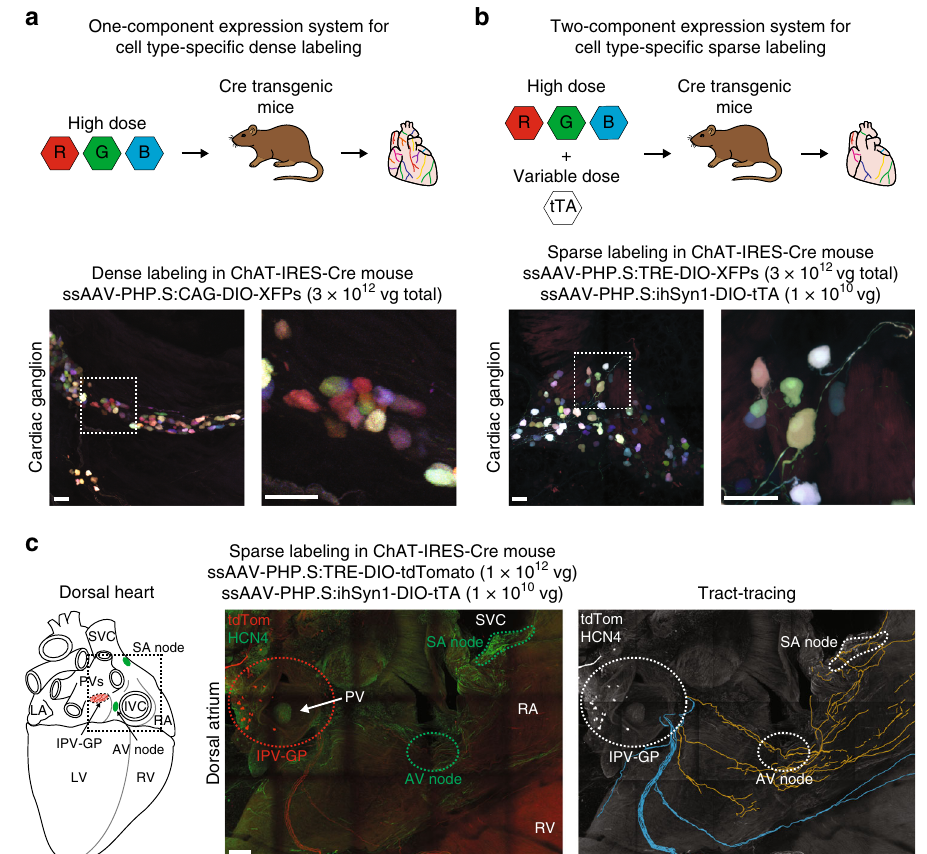
Fig. 2 AAV-based labeling and tracing of cholinergic neurons on the heart. a Schematic of the one-component expression system for cell type-speci fi c, dense multicolor labeling (top). To densely label cholinergic neurons in cardiac ganglia, ChAT-IRES-Cre mice were systemically co-administered 3 Cre- dependent vectors expressing either mRuby2, mNeonGreen, or mTurquoise2 from the ubiquitous CAG promoter (ssAAV-PHP.S:CAG-DIO-XFPs) (1 × 10 12 vector genomes (vg) each; 3 × 10 12 vg total). A MIP image of a densely labeled cardiac ganglion (bottom left). Inset shows a higher magni fi cation image (bottom right). b Schematic of the two-component expression system for cell type-speci fi c, sparse multicolor labeling (top). Expression of XFPs is dependent on cotransduction of an inducer in Cre-expressing cells. The dose of the inducer vector can be titrated to control extent of XFP labeling. To sparsely label cholinergic neurons in cardiac ganglia, ChAT-IRES-Cre mice were systemically co-administered 3 Cre-dependent vectors expressing XFPs from the TRE-containing promoter (ssAAV-PHP.S:TRE-DIO-XFPs) (1 × 10 12 vg each; 3 × 10 12 vg total) and a Cre-dependent inducer vector expressing the tTA from the ihSyn1 promoter (ssAAV-PHP.S:ihSyn1-tTA) (1 × 10 10 vg). A MIP image of a sparsely labeled cardiac ganglion (bottom left). Inset shows a higher magni fi cation image (bottom right). c To trace cholinergic fi bers, presumably from cardiac ganglia, sparse labeling was performed by systemically co-administering ssAAV-PHP.S:TRE-DIO-tdTomato at a high dose (1 × 10 12 vg) and ssAAV-PHP.S:ihSyn1-DIO-tTA at a lower dose (1 × 10 10 vg). Cartoon of the dorsal heart depicting the orientation of images (left). A MIP image of the dorsal atrium with native tdTomato fl uorescence (red) and HCN4 staining (green) (middle). Fibers were traced with neuTube and overlaid on a grayscale MIP image (right). Orange fi bers coursed along the right atrium (RA) including the sinoatrial (SA) and atrioventricular (AV) nodes and blue fi bers along the ventricles. Scale bars are 50 µ m ( a , b ) and 200 µ m ( c ). All images were acquired on tissue collected 3 weeks after intravenous injection. IPV-GP inferior pulmonary vein-ganglionated plexus, IVC inferior vena cava, LA left atrium, LV left ventricle, PV pulmonary vein, RV right ventricle, SVC superior vena